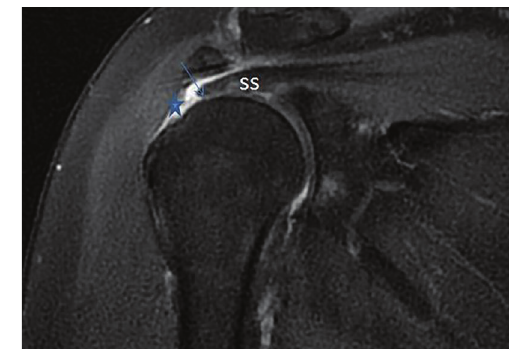
Figure 1b. - 48-year-old male patient. The supraspinatus tendon (small blue star) is not observed in the subacromial area in the shoulder MRI taken for shoulder pain. The supraspinatus (SS) tendon is seen as total ruptured. Proximal retraction of the ruptured fibers is observed (thin blue